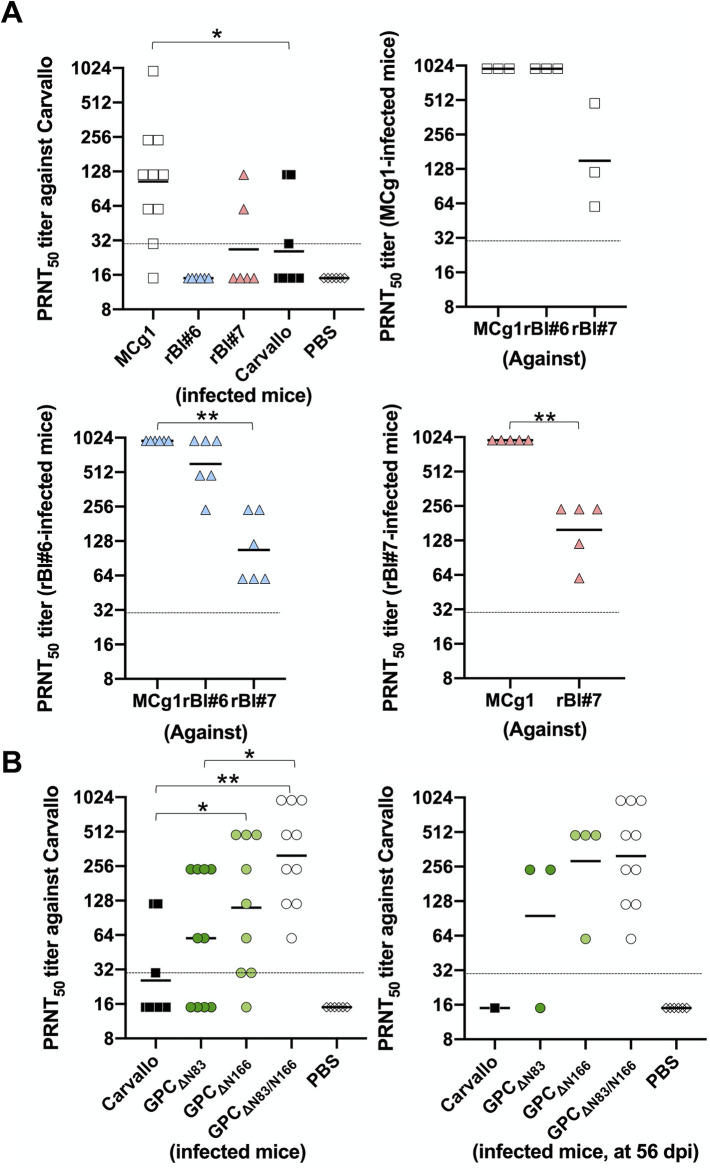
Individual PRNT50 titers.(A) Individual PRNT50 titers from Table 1. (B) Individual PRNT50 titers from Table 2. The solid bar and the dashed line indicate the geometric mean of the titers and the detection limits, respectively. The serum dilution factor is 30 to 960 times, and PRNT50 titer lower than 30 was plotted as 15. Statistically significant differences compared with Carvallo are indicated by asterisks (*, P<0.05 and **, P<0.01 by Mann-Whitney U test).